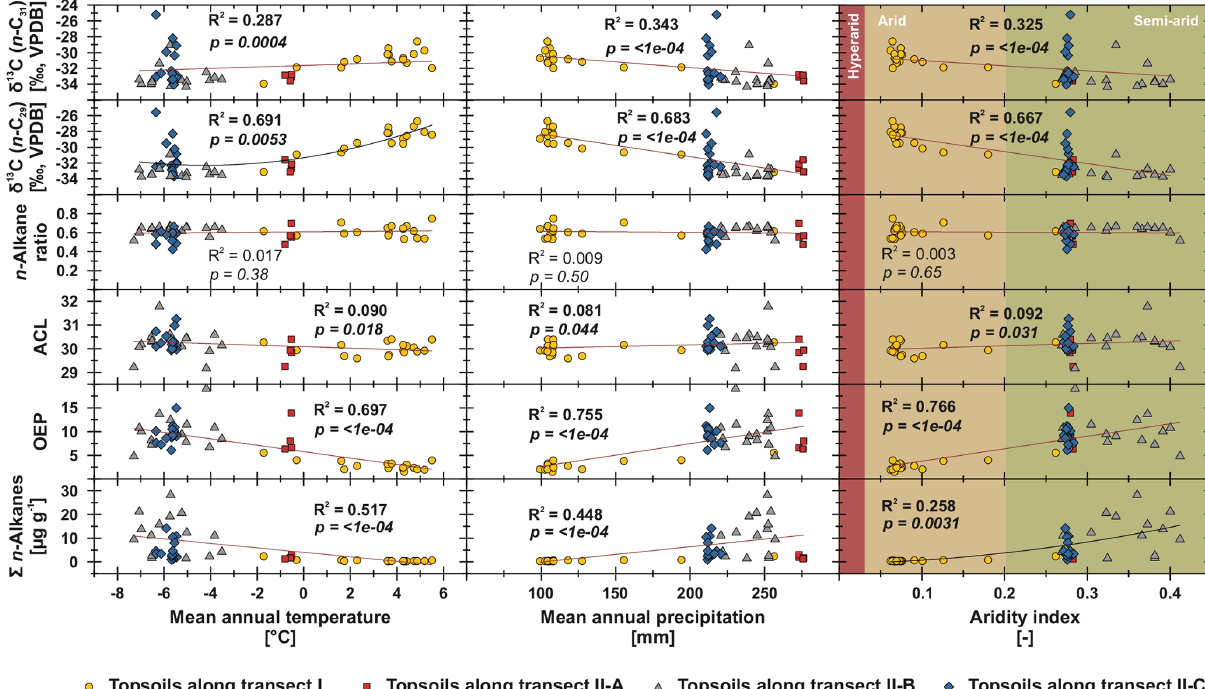
Figure 6. n -Alkane concentration ( n -C 25 – n -C 35 ), OEP, ACL, n -alkane ratio ( n -C 31 / ( n -C 29 + n -C 31 )) and compound-specific δ 13 C ( n - C 29 and n -C 31 ) from Mongolian topsoils plotted against climatic parameters (MAP, MAT and AI; Fick and Hijmans, 2017; Trabucco and Zomer, 2019). Red trend lines illustrate linear regressions, and black lines illustrate polynomial regressions. Bold values indicate significance ( α = 0 .